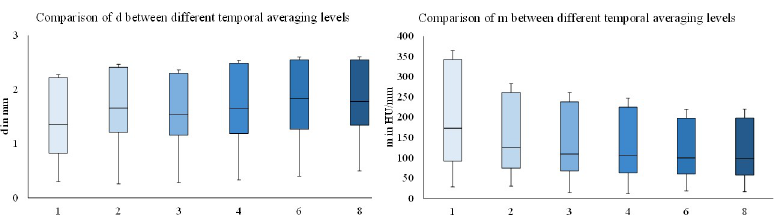
Fig 7. Boxplots of the comparison of contour sharpness parameters between different levels of temporal averaging. Comparisons of the distance between 25–75% of the maximal grey value (d; left diagram) and the slope in the contour (m; right diagram) were performed between the different temporal averaging levels (1 dataset and combination of 2, 3, 4, 6 and 8 datasets). Higher levels of temporal averaging showed reduced contour sharpness parameters, specifically higher values for the distance (d) and lower values for the slope